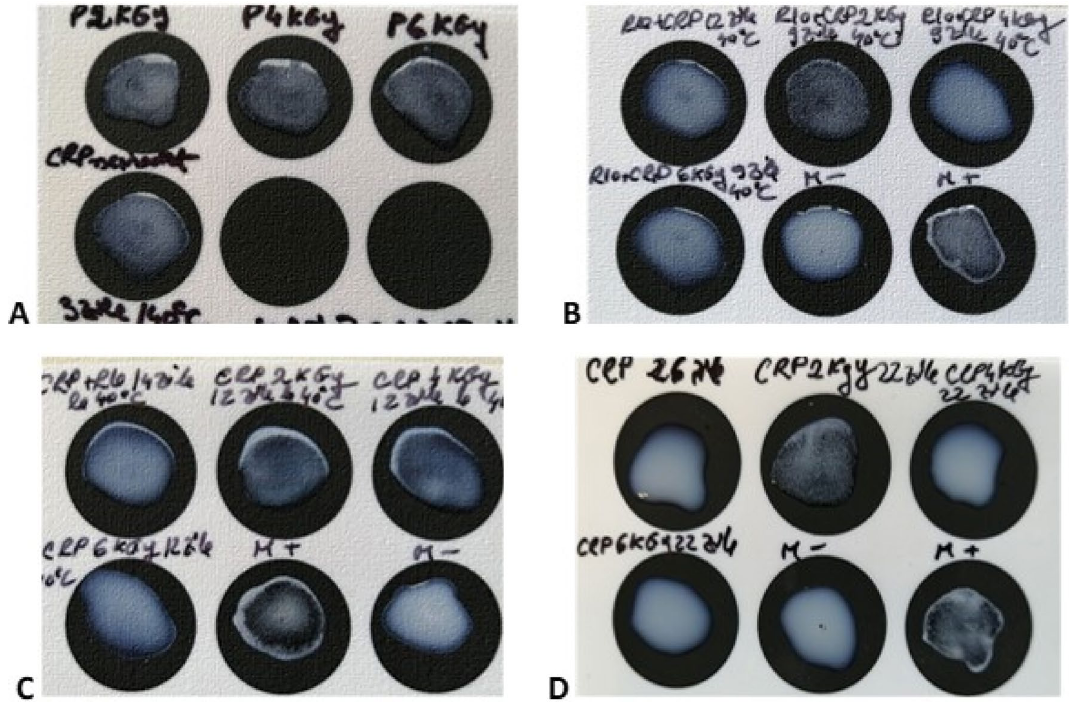
Figure 4. Agglutination results at different testing intervals: ( A ) after 3 days incubation at 40 °C; ( B ) after 9 days incubation at 40 °C; ( C ) after 12 days incubation at 40 °C; ( D ) after 22 days incubation at 40